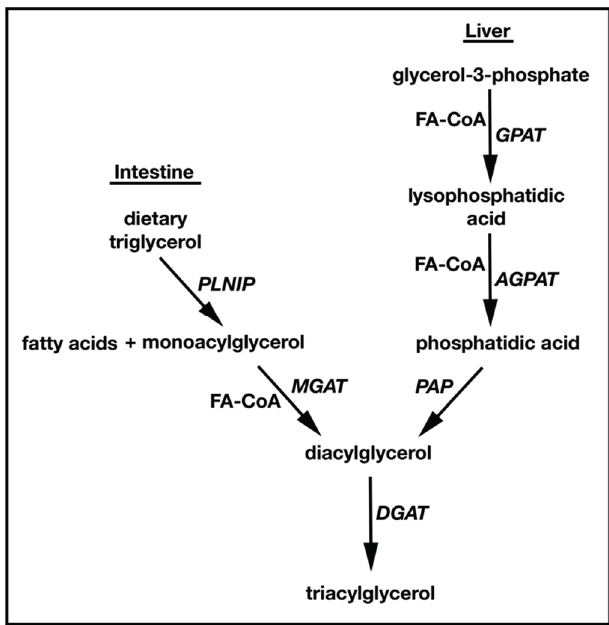
Figure 1. Schematic representation of the two triglyceride synthesis pathways using either MAG or G3P as the initial acyl acceptor. The G3P pathway is dominant in liver, whereas MGAT mediated MAG to TAG conversion is predominant in the